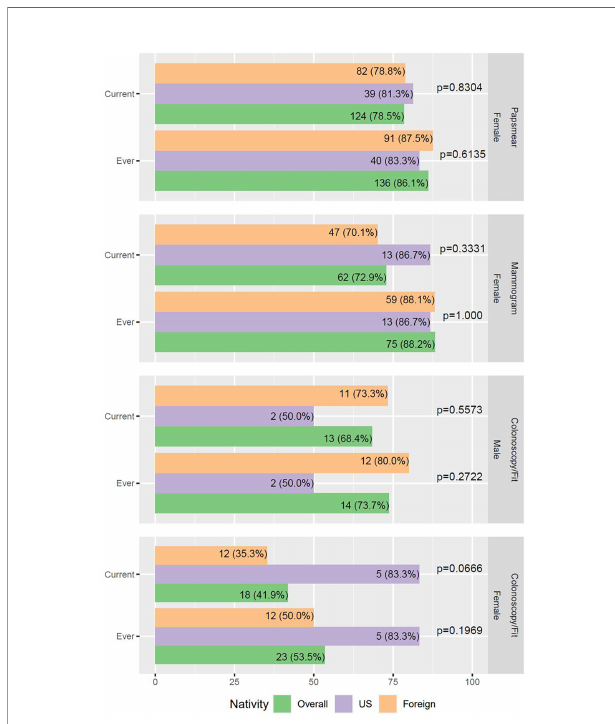
FIGURE 2 | Cancer screening rates in survey participants. Two-sided p- values from Chi-square test or Fisher ’ s exact test are reported. Age inclusion: 21-65yo females for papsmear (N = 158); 40-75yo females for mammogram (N = 85); 50-75yo for colonoscopy/FIT (N =